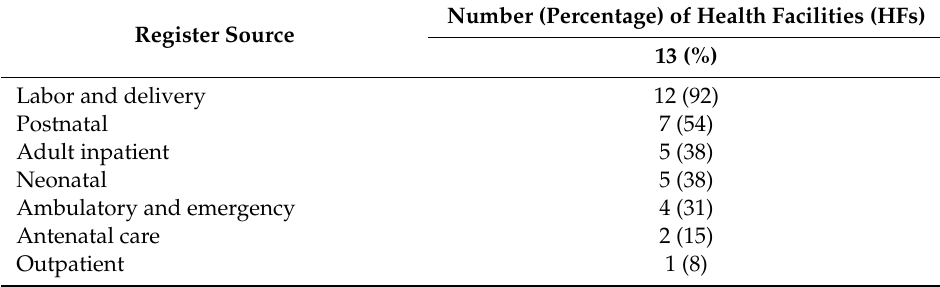
Table 1. Sources for identifying health facility